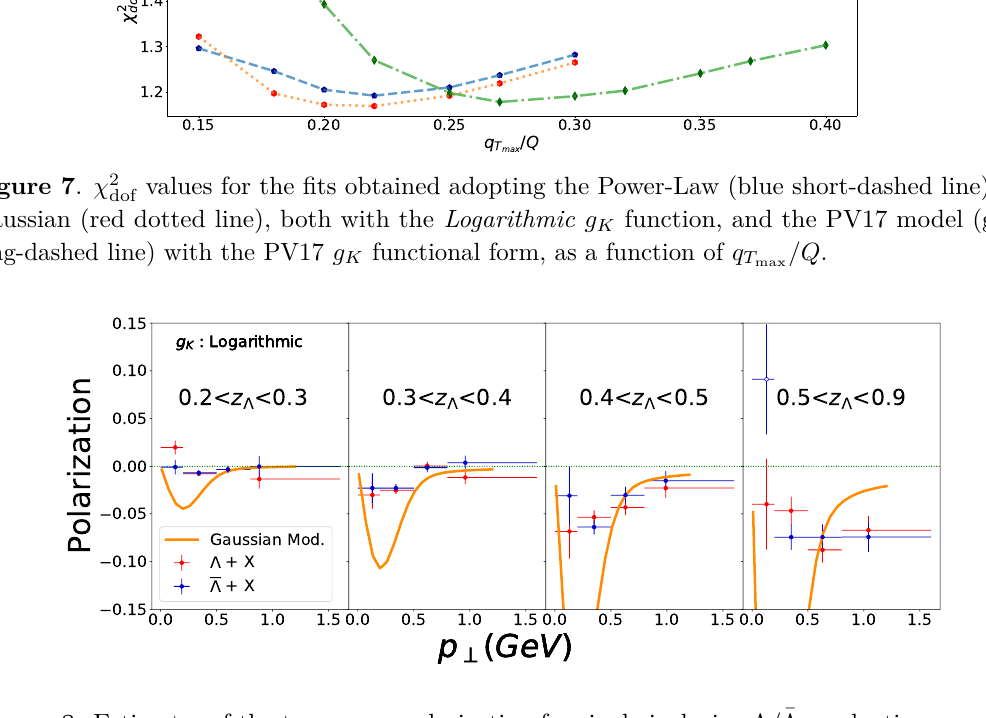
Figure 8 . Estimates of the transverse polarization for single-inclusive Λ / with Belle data. The results are obtained using eqs. (4.3), (4.5) and (4.8) and the parameter values of table 2, for the Gaussian model (with the logarithmic functional form for g